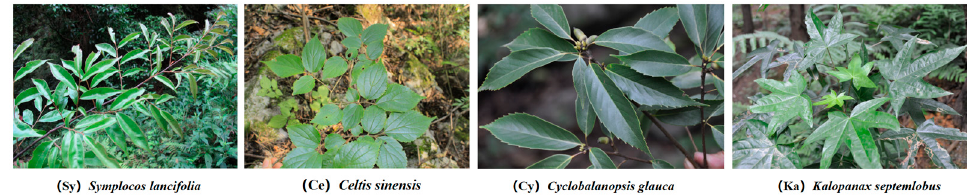
Figure 2. Images of the four tree